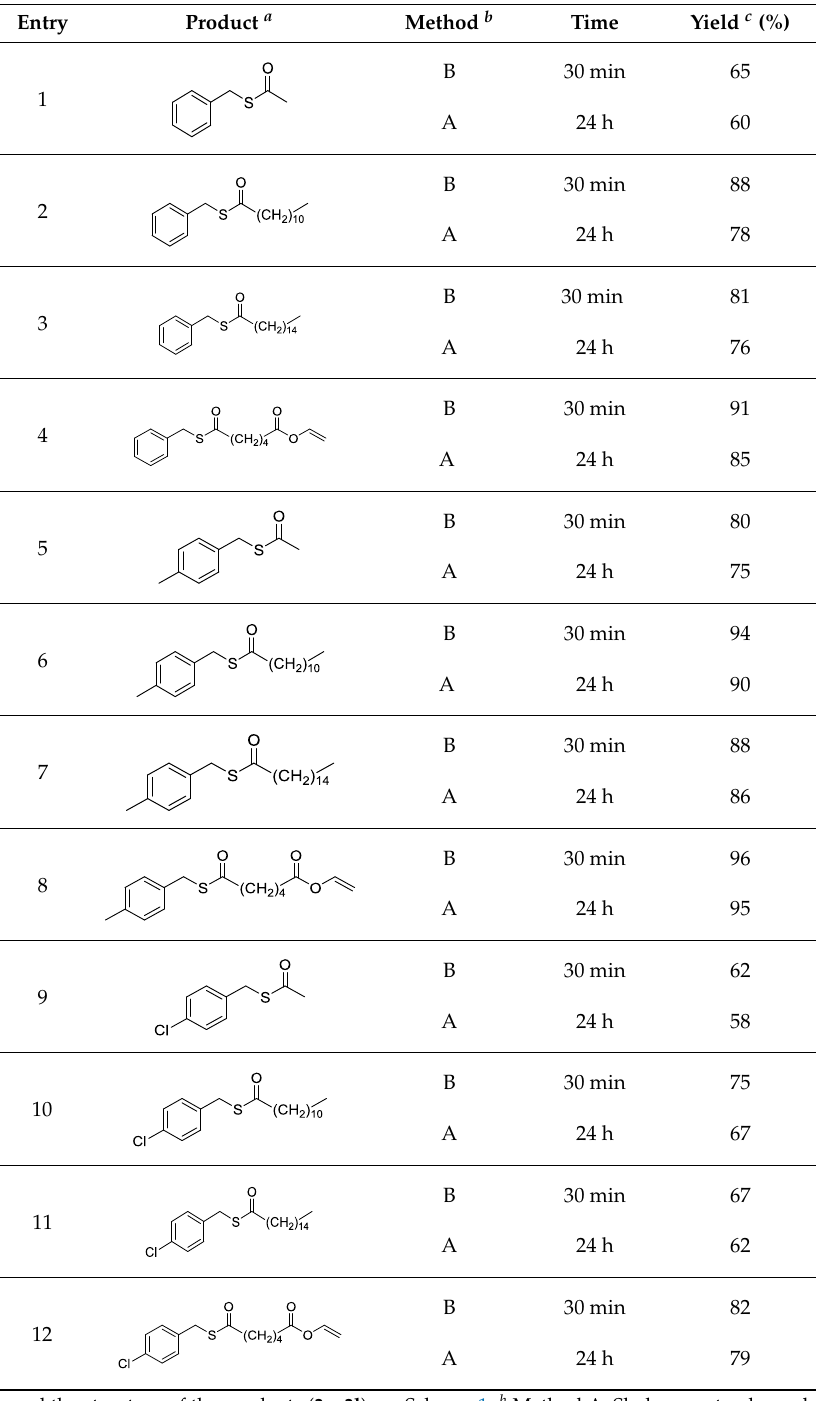
Table 1. Shaker and continuous flow synthesis of thioesters catalysed by Lipozyme TL IM.